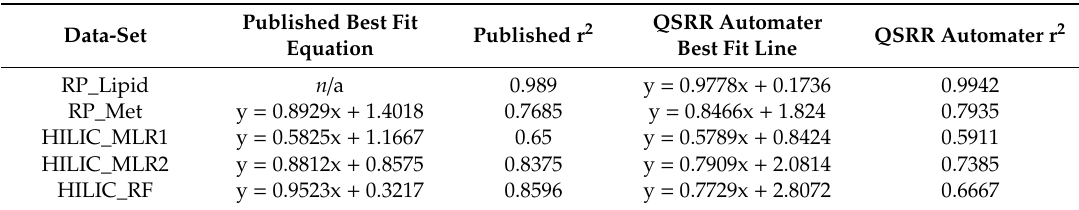
Table 2. Best fit least squares lines to the data in Figure 2. In an ideal fit y = x and r 2 = 1. Rp_lipid does not have an equation for one value that is provided in the paper (though they did many tests for various reasons). Data-set names are from Table